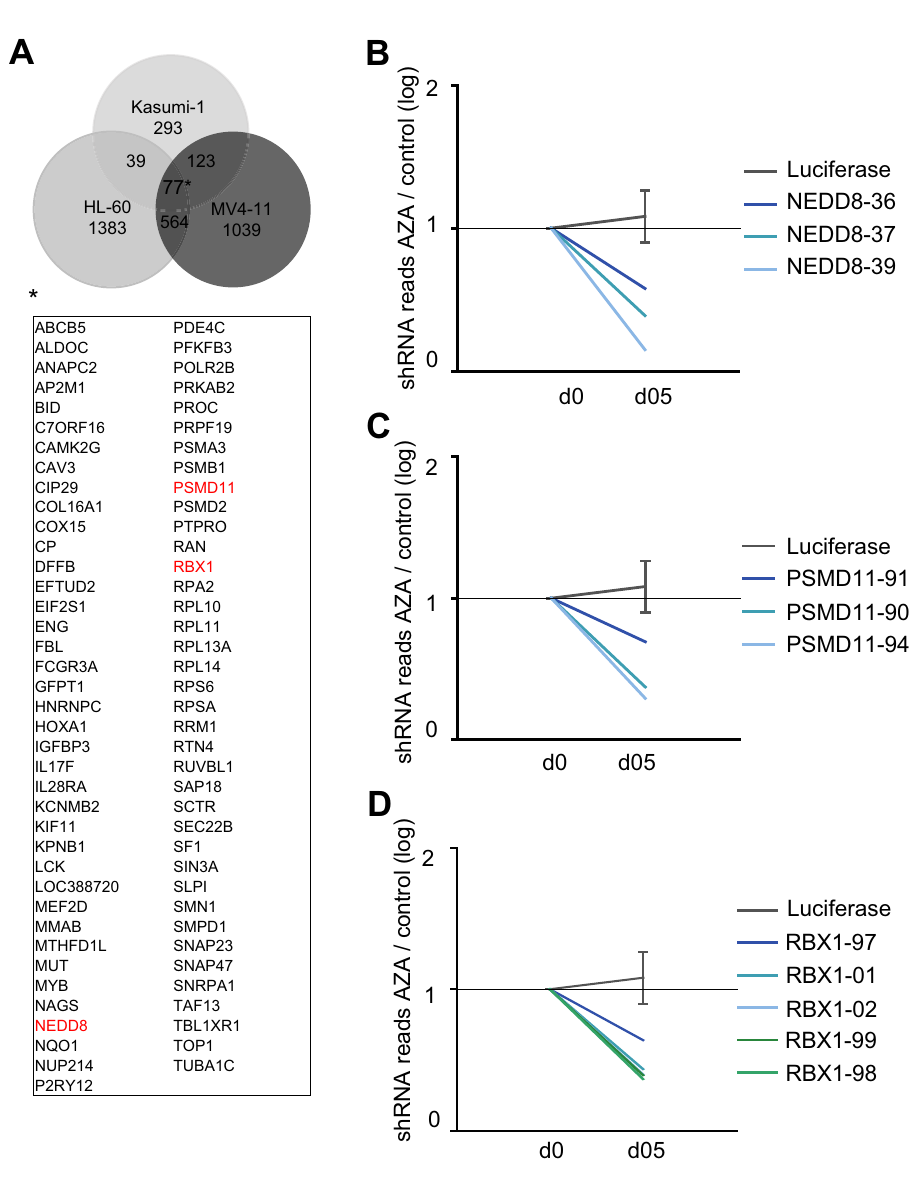
Figure 3. Comparison of results in the Azacytidine group. ( A ) Venn diagram shows the number of potential candidates in each tested cell line in the AZA/d05 analysis and visualizes mutually depleted genes (fold change < 0.6) with at least two independent shRNAs targeting the same gene. Among them are NEDD8, RBX1 and PSMD11, all part of the proteasome complex. ( B – D ) Plots showing median depletion of different shRNAs targeting NEDD8 ( B ), PSMD-11 ( C ) and RBX-1 ( D ) in HL-60, Kasumi-1 and